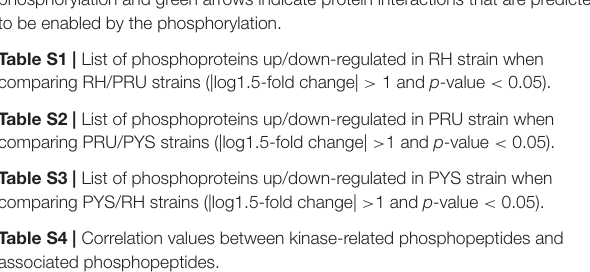
Figure S1 | GO function network of upregulated phosphoproteins in RH strain when comparing RH/PRU strains. The clusters coincide with the GO functional categories of the DEPs and are color-coded as indicated. Red, green and blue clusters denote GO terms related to biological process, cellular component and molecular function, respectively. The dark colored nodes represent significantly enriched GO terms ( p -value ≤ 0.05). The solid and dashed arrows between nodes represent direct and indirect associations between GO terms, respectively. Figure S2 | GO function network of downregulated phosphoproteins in RH strain when comparing RH/PRU strains. The clusters coincide with the GO functional categories of the DEPs and are color-coded as indicated. Red, green and blue clusters denote GO terms related to biological process, cellular component and molecular function, respectively. The dark colored nodes represent significantly enriched GO terms ( p -value ≤ 0.05). The solid and dashed arrows between nodes represent direct and indirect associations between GO terms, respectively. Figure S3 | GO function network of upregulated phosphoproteins in PRU strain when comparing PRU/PYS strains. The clusters coincide with the GO functional categories of the DEPs and are color-coded as indicated. Red, green, and blue clusters denote GO terms related to biological process, cellular component and molecular function, respectively. The solid and dashed arrows between nodes represent direct and indirect associations between GO terms, respectively.